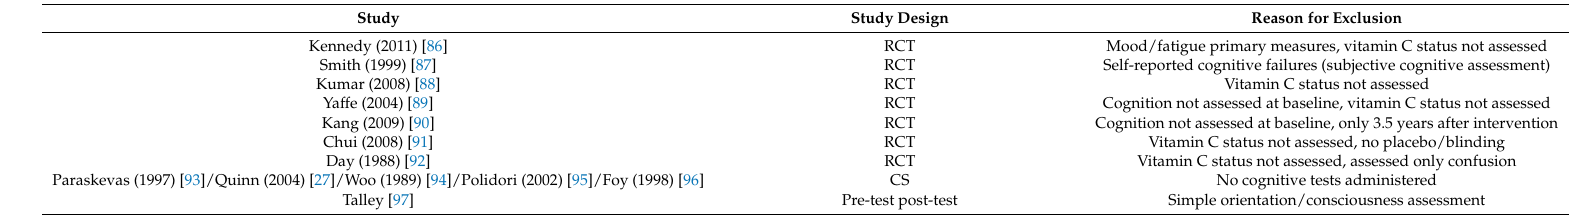
Legend: RCT = Randomised control trial, CS =